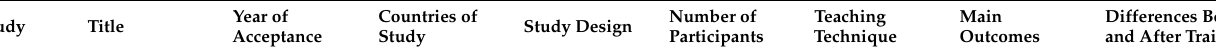
Table 3. Overview of all included studies (n = 6) on tutorials for dental students with country of study, study design, number of participants, teaching technique and main outcomes before and after the completion of the